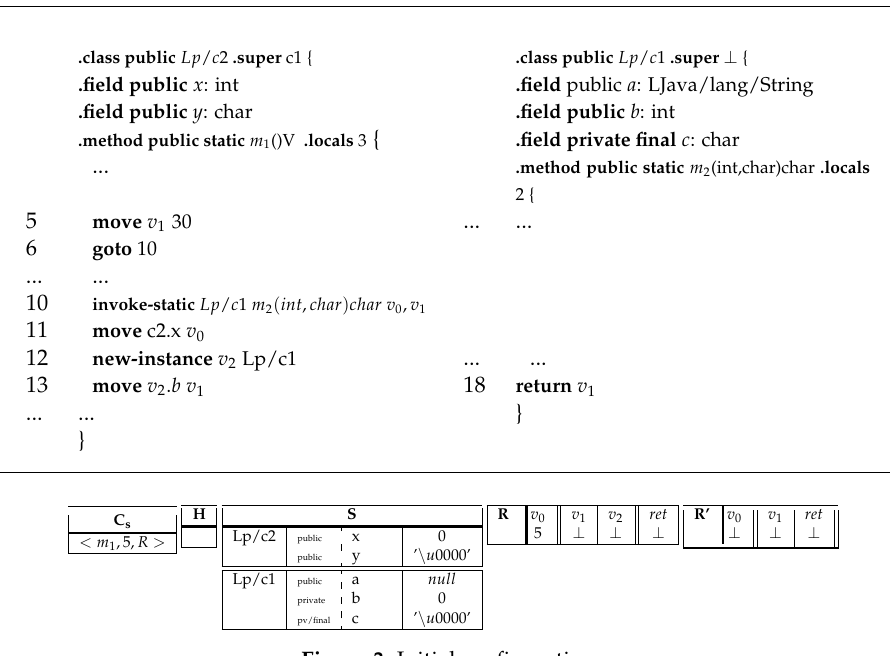
Figure 3. Initial